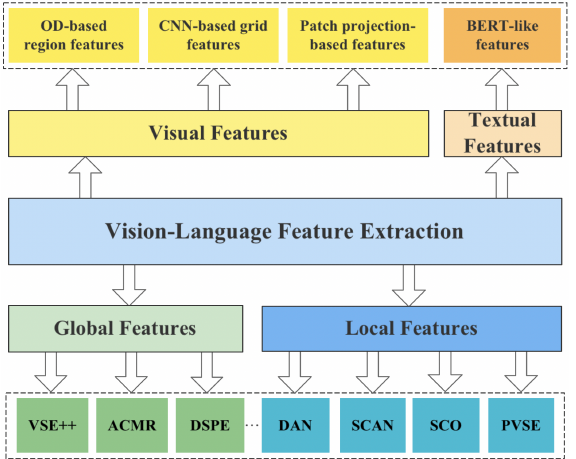
Figure 3. Classified diagram of V-L feature